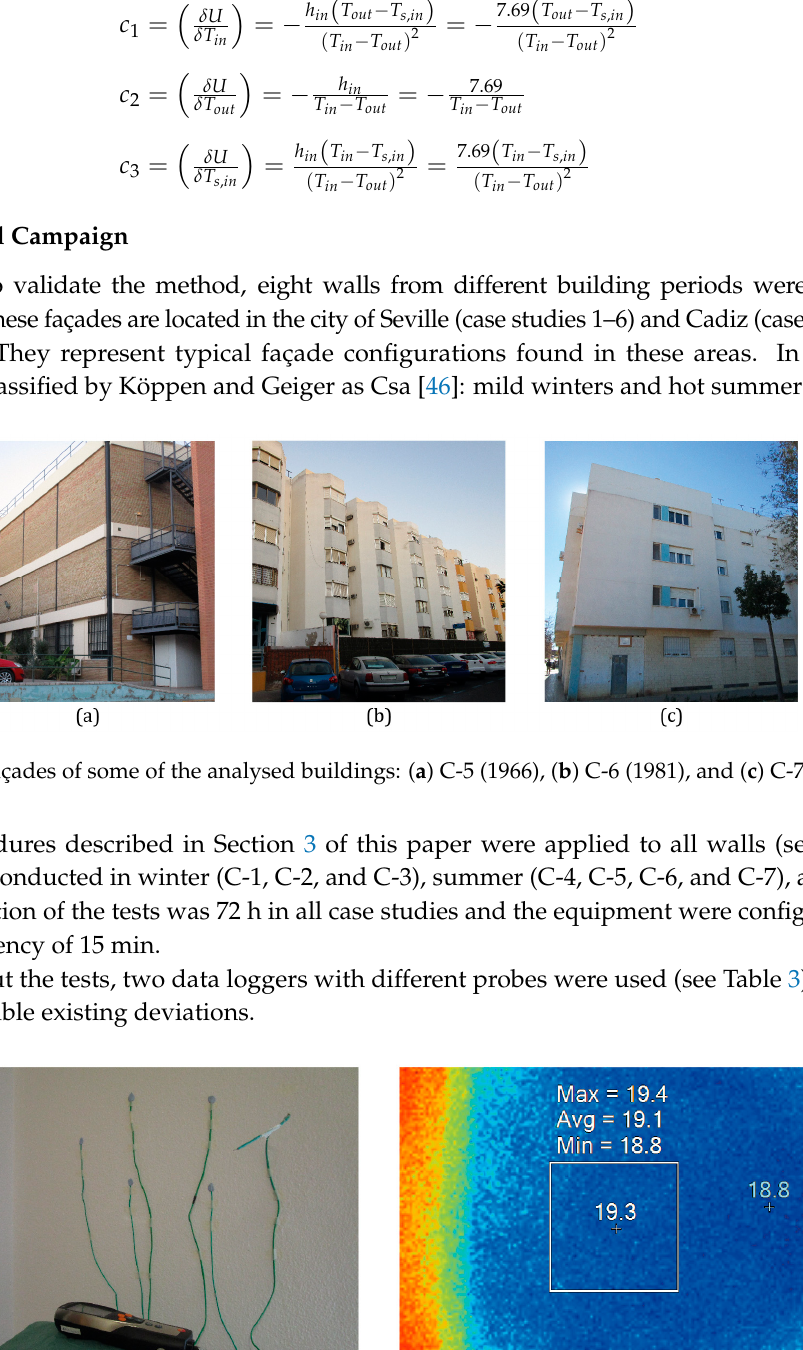
Figure 2. ( a ) Installation of the equipment and ( b ) internal qualitative assessment by means of infrared thermography.